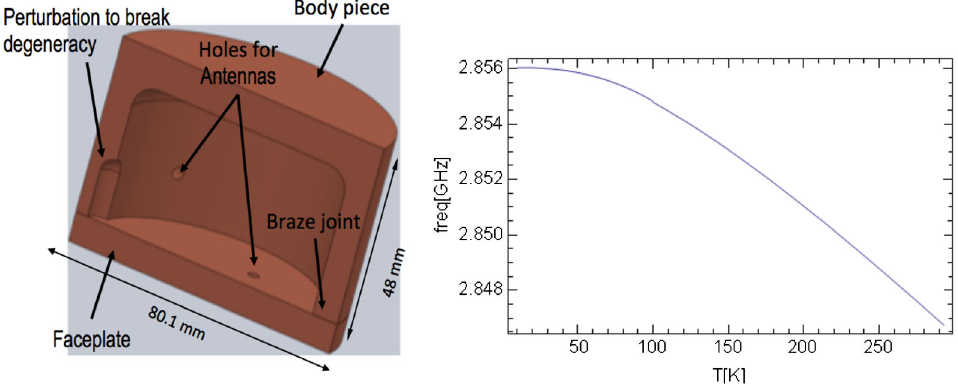
FIG. 13. (left) Cutaway model for section of S-band Cu pillbox test cavity. The faceplate is brazed to the bottom, while on the left a feature is included to break dipole mode degeneracies. Through holes host two antennas for S 11 and S 21 tests. (right) Calculation of temperature dependence in the TM 010 accelerating mode using the thermal coefficient of expansion for